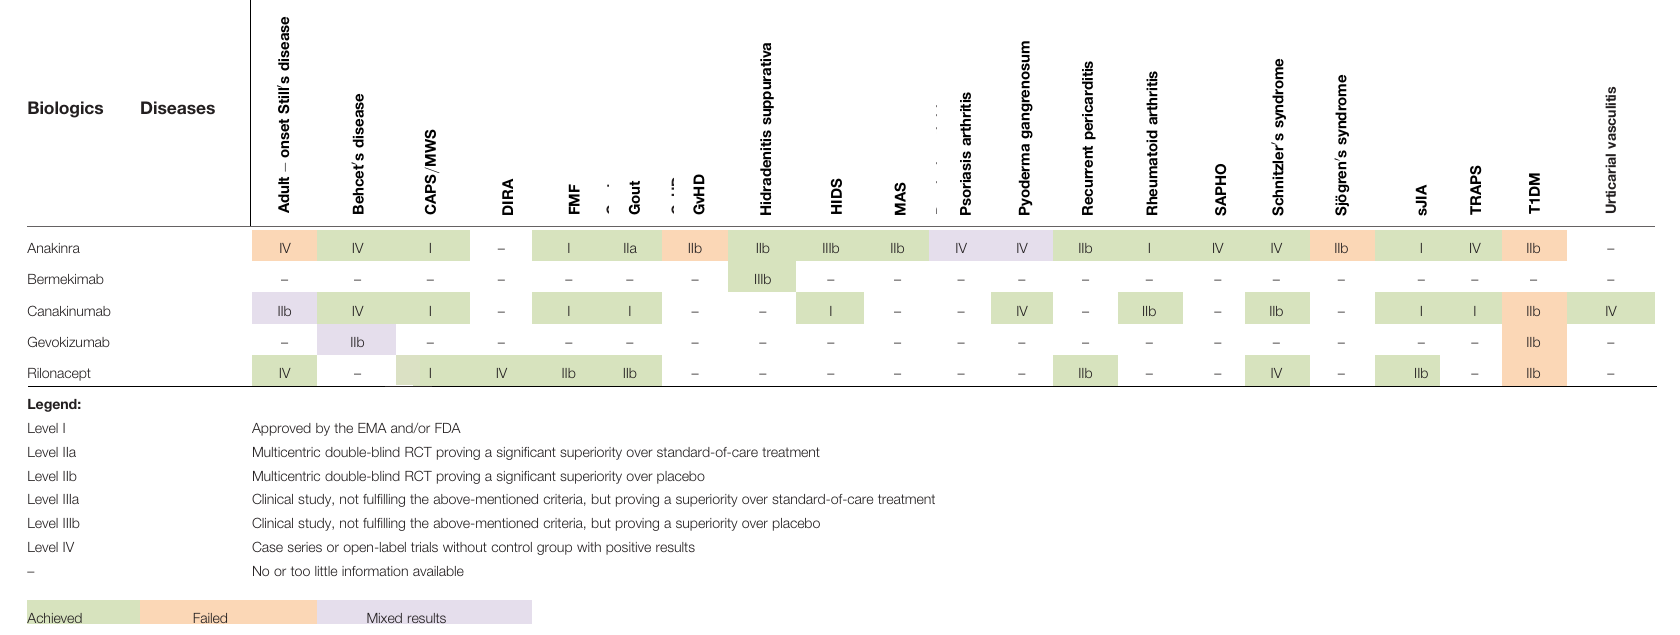
TABLE 2 | Summary of the